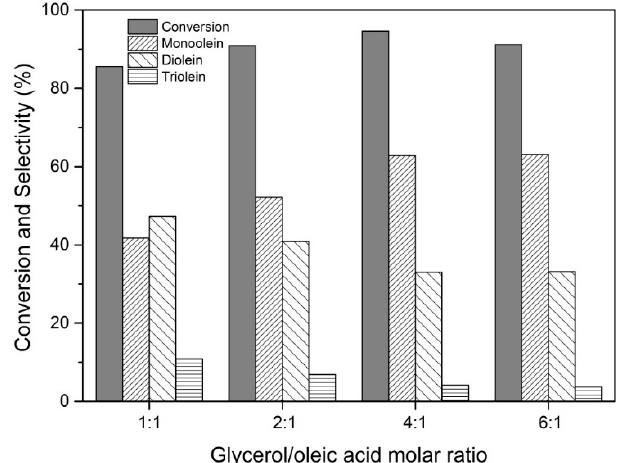
Figure 8. Effect of glycerol/oleic acid molar ratio on oleic acid conversion and product distribution using S-N 2 -HPW catalyst in esterification of glycerol with oleic acid at 160 °C for 3 h with 2.5 wt % of catalyst loading and glycerol/oleic acid molar ratios of 1:1, 2:1, 4:1, and 6:1.